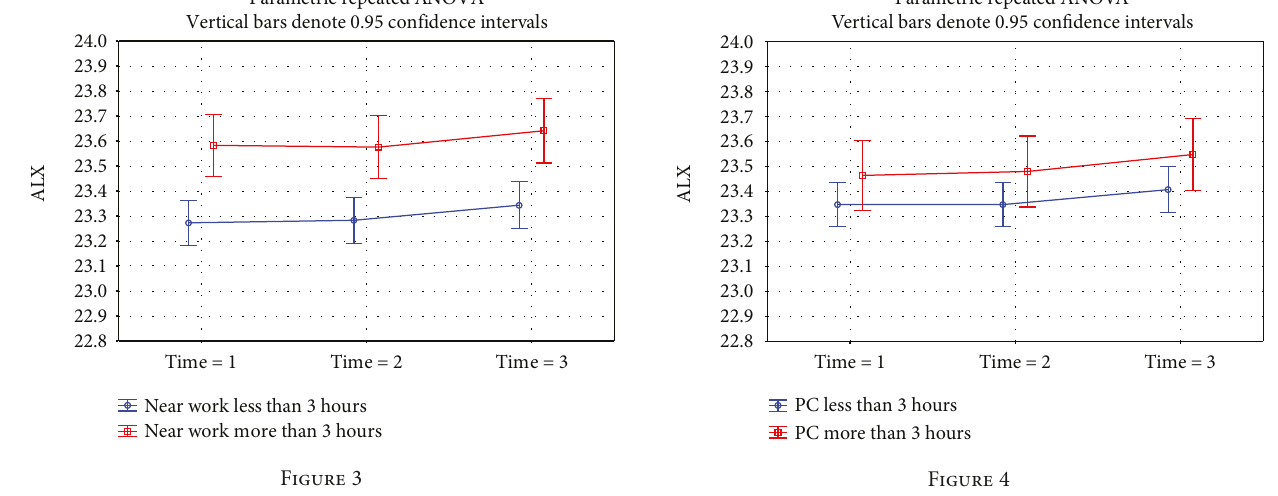
Parametric repeated ANOVA Vertical bars denote 0.95 confidence